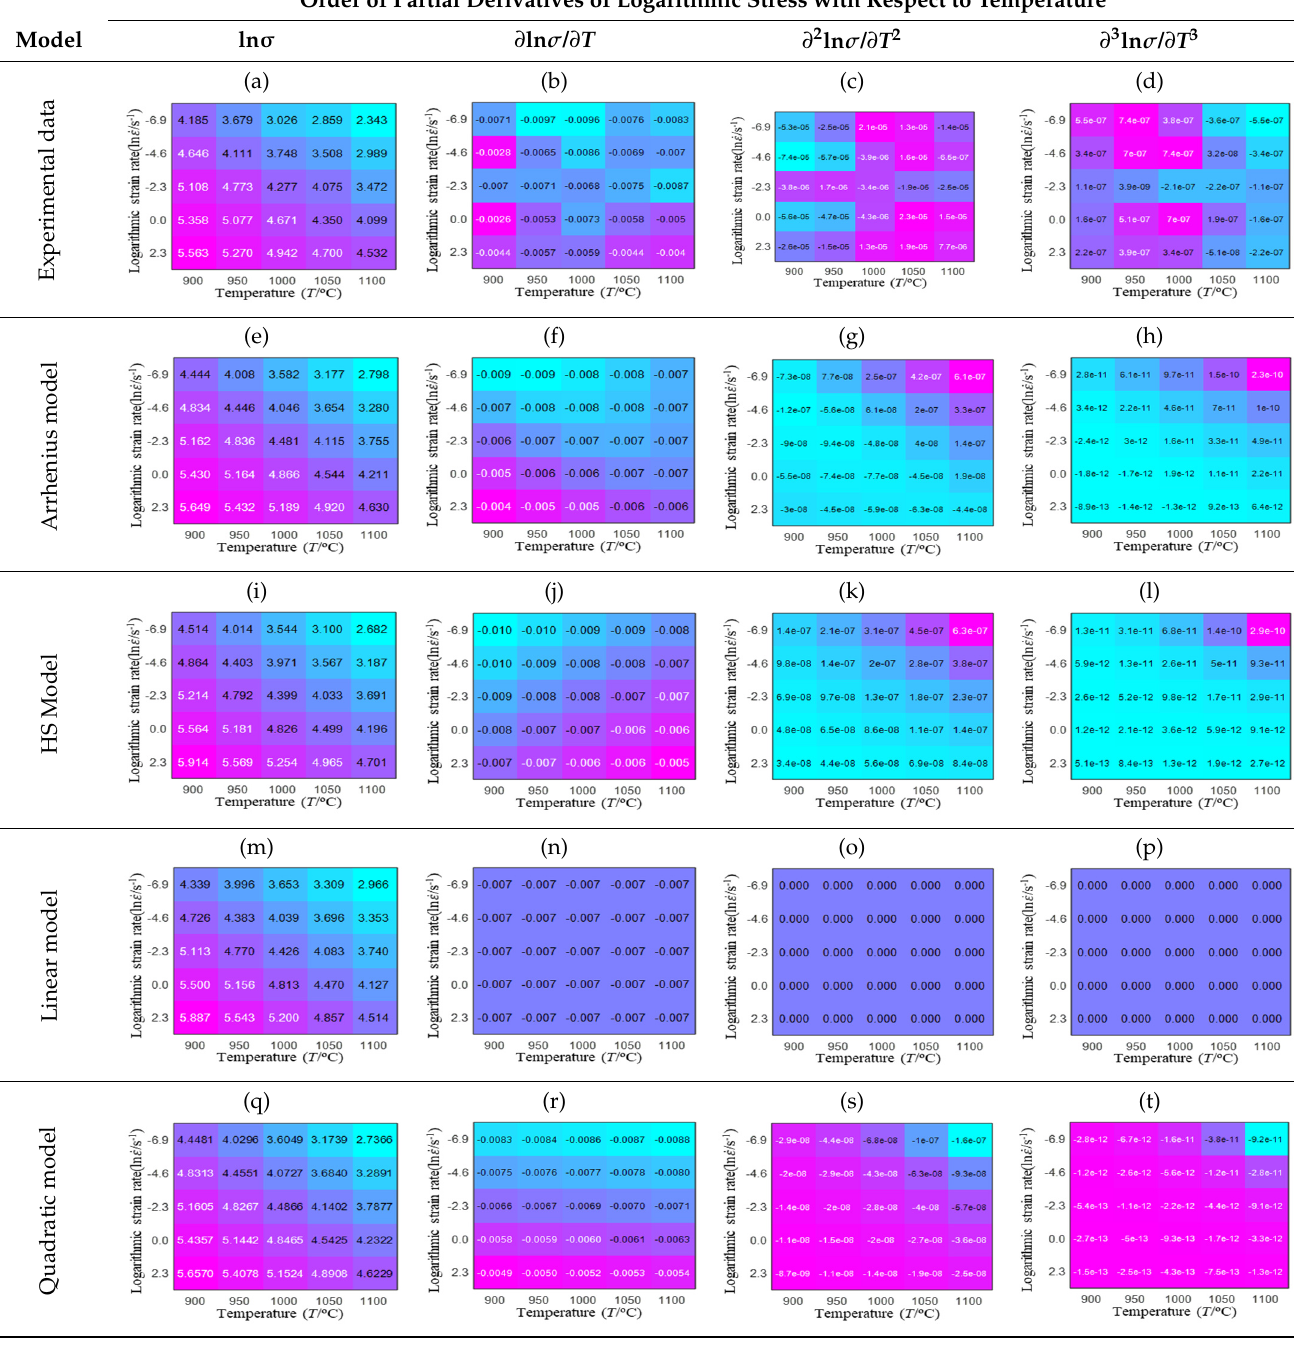
Table 8. The first, second and third partial derivative of logarithmic stress with respect to temperature Table 8. The fi rst, second and third partial derivative of logarithmic stress with respect to tempera- Table 8. The fi rst, second and third partial derivative of logarithmic stress with respect to tempera- Table 8. The fi rst, second and third partial derivative of logarithmic stress with respect to tempera- Table 8. The fi rst, second and third partial derivative of logarithmic stress with respect to tempera- Table 8. The fi rst, second and third partial derivative of logarithmic stress with respect to tempera- Table 8. The fi rst, second and third partial derivative of logarithmic stress with respect to tempera- Table 8. The fi rst, second and third partial derivative of logarithmic stress with respect to tempera- Table 8. The fi rst, second and third partial derivative of logarithmic stress with respect to tempera- Table 8. The fi rst, second and third partial derivative of logarithmic stress with respect to tempera- Table 8. The fi rst, second and third partial derivative of logarithmic stress with respect to tempera- Table 8. The fi rst, second and third partial derivative of logarithmic stress with respect to tempera- Table 8. The fi rst, second and third partial derivative of logarithmic stress with respect to tempera- Table 8. The fi rst, second and third partial derivative of logarithmic stress with respect to tempera- Table 8. The fi rst, second and third partial derivative of logarithmic stress with respect to tempera- Table 8. The fi rst, second and third partial derivative of logarithmic stress with respect to tempera- Table 8. The fi rst, second and third partial derivative of logarithmic stress with respect to tempera- Table 8. The fi rst, second and third partial derivative of logarithmic stress with respect to tempera- for different models at ε = 0.04. Table 8. The fi rst, second and third partial derivative of logarithmic stress with respect to tempera- Table 8. The fi rst, second and third partial derivative of logarithmic stress with respect to tempera- Table 8. The fi rst, second and third partial derivative of logarithmic stress with respect to tempera- ture for di ff erent models at 𝜀 = 0.04 . ture for di ff erent models at 𝜀 = 0.04 . ture for di ff erent models at 𝜀 = 0.04 . ture for di ff erent models at 𝜀 = 0.04 . ture for di ff erent models at 𝜀 = 0.04 . ture for di ff erent models at 𝜀 = 0.04 . ture for di ff erent models at 𝜀 = 0.04 . ture for di ff erent models at 𝜀 = 0.04 . ture for di ff erent models at 𝜀 = 0.04 . ture for di ff erent models at 𝜀 = 0.04 . ture for di ff erent models at 𝜀 = 0.04 . ture for di ff erent models at 𝜀 = 0.04 . ture for di ff erent models at 𝜀 = 0.04 . ture for di ff erent models at 𝜀 = 0.04 . ture for di ff erent models at 𝜀 = 0.04 . ture for di ff erent models at 𝜀 = 0.04 ture for di ff erent models at 𝜀 = 0.04 . ture for di ff erent models at 𝜀 = 0.04 . ture for di ff erent models at 𝜀 = 0.04 . ture for di ff erent models at 𝜀 = 0.04 . . . . . . . .